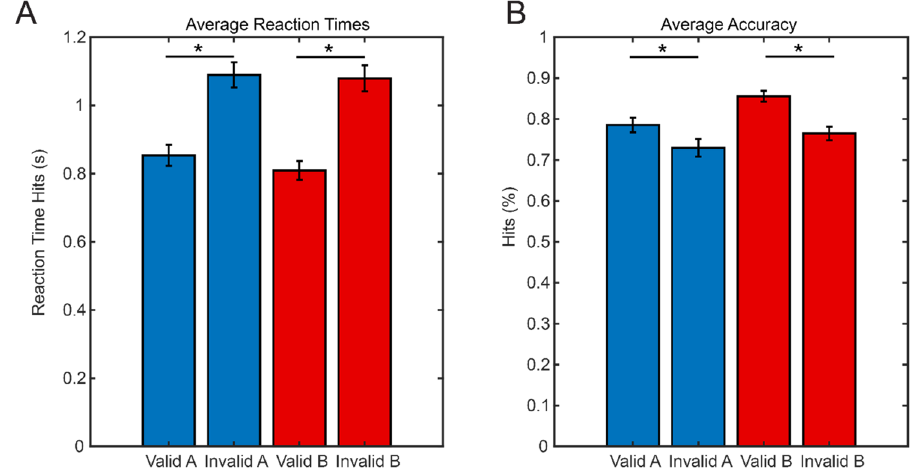
Figure 2. Average reaction times ( A ) and accuracy ( B ) for valid and invalid